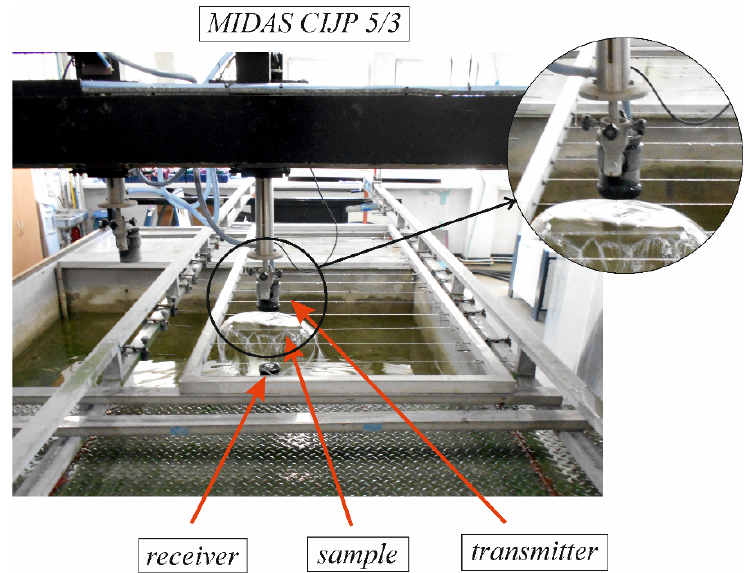
Figure 2. Experimental setup for tests by through-transmission method.